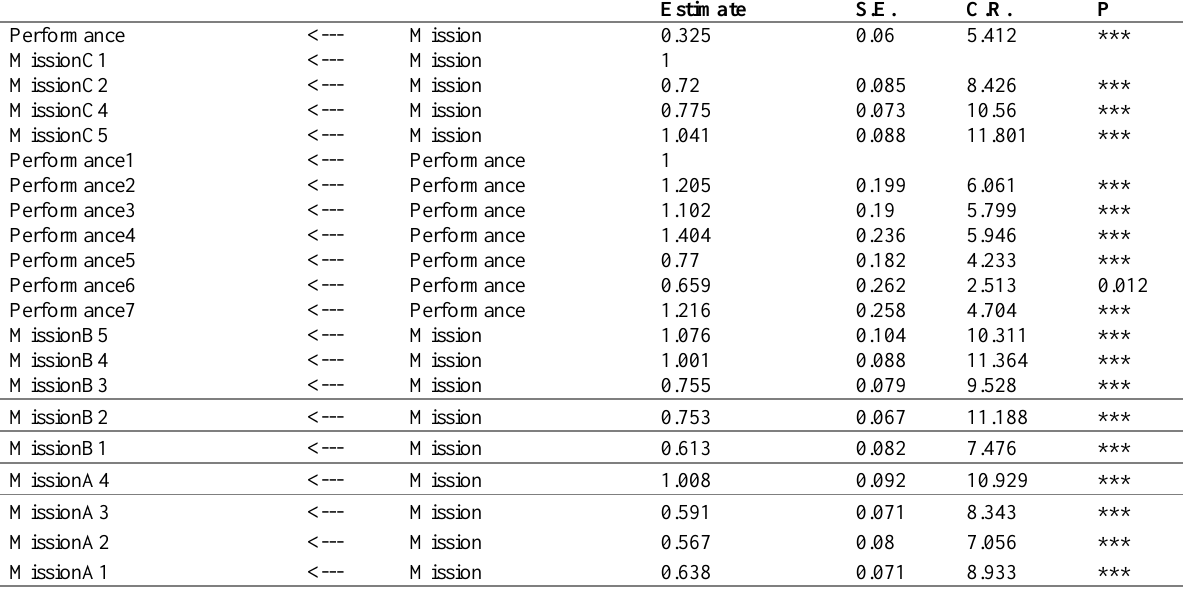
Table 9: Regression Weights on mission and performance